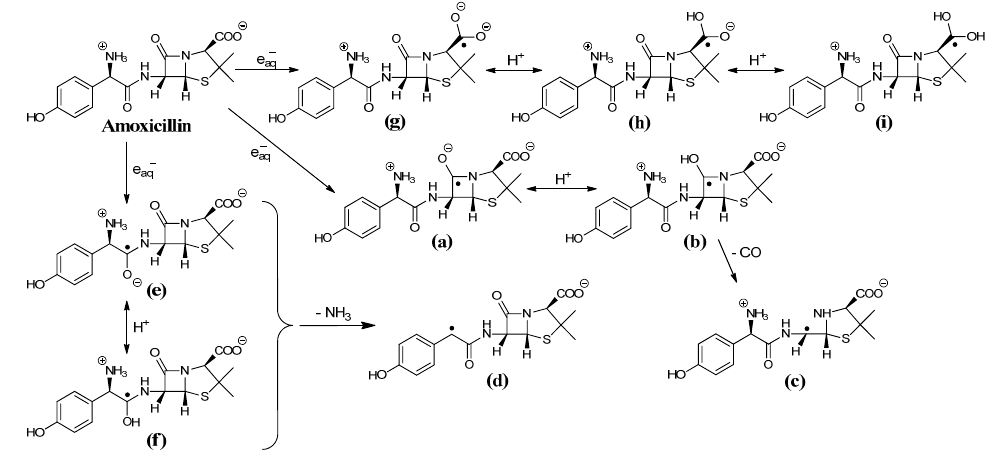
Figure 2. ( A ) Transient absorption spectra of intermediates in N 2 -saturated 1 × 10 − 4 mol·dm − 3 amoxicillin solution with 0.5 mol·dm − 3 tert -butanol added 10 μ s (a); 80 μ s (b); and 580 μ s (c) after the pulse. Inset: First-order decay fit at 325 nm, rate constants: 2.3 × 10 3 s − 1 and 1.1 × 10 3 s − 1 ; ( B ) Kinetic trace recorded at 485 nm (black) with inset showing the trace at 380 nm (blue) in the same solution as specified in ( A ); ( C ) Kinetic trace recorded at 400 nm in N 2 -saturated 2 × 10 − 5 mol·dm − 3 6-aminopenicillanic acid solution with 0.5 mol·dm − 3 tert -butanol added. Dose/pulse was measured to be 20 Gy in each case.